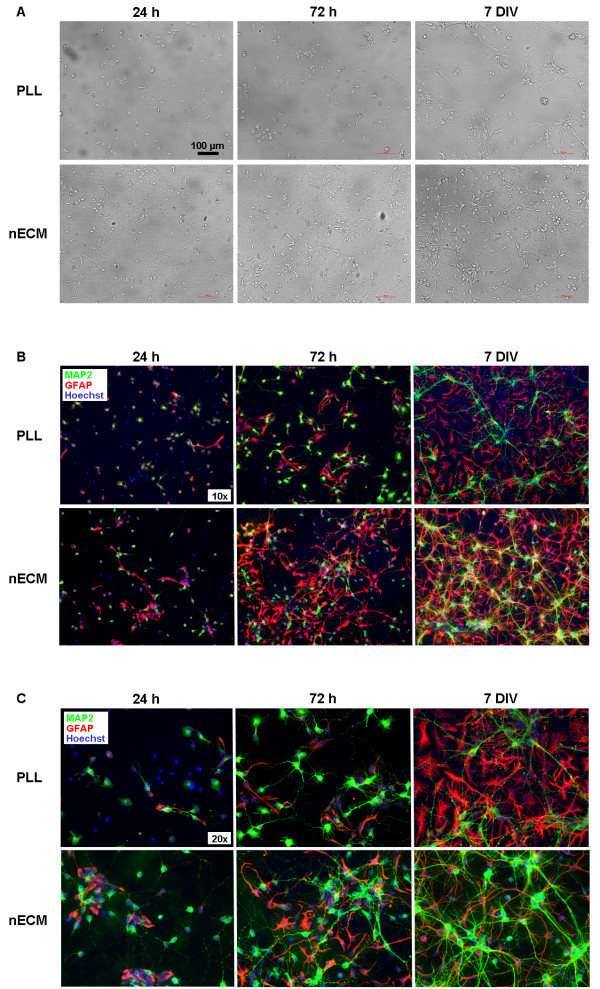
Establishment of primary hippocampal cultures on PLL- and nECM-coated coverslips. Hippocampal cells were seeded either on PLL- or nECM-coated coverslips and culture progression was observed on both substrates for 7 days. (A) Bright field microscopic images taken at 24 h, 72 h and 7 days of culture, respectively. Scale bars, 100 μm. (B) Immunofluorescence analyses (×10 objective). Neuronal and glial cells grown for 24 h, 72 h and 7 days on both substrates were fixed and immunolabelled with anti-MAP2 (green) and anti-GFAP (red) antibodies, respectively. Cell nuclei were counterstained with Hoechst (blue). (C) Magnification (×20 objective) of immunofluorescence images shown in panel B. All images are representative of three independent experiments.